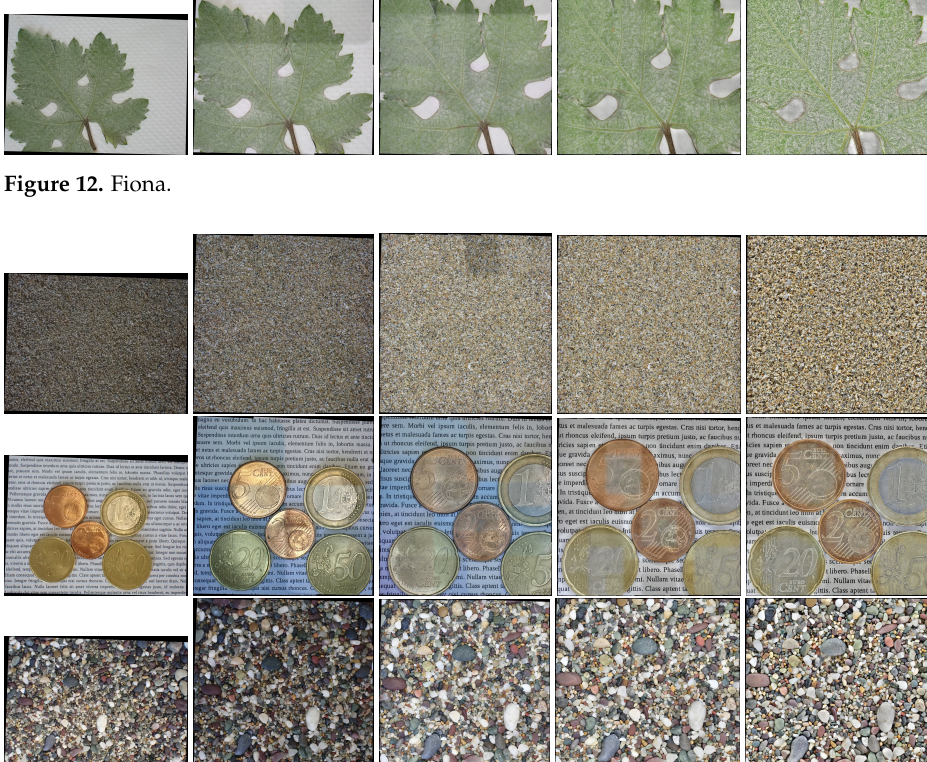
Figure 13. Approximately planar